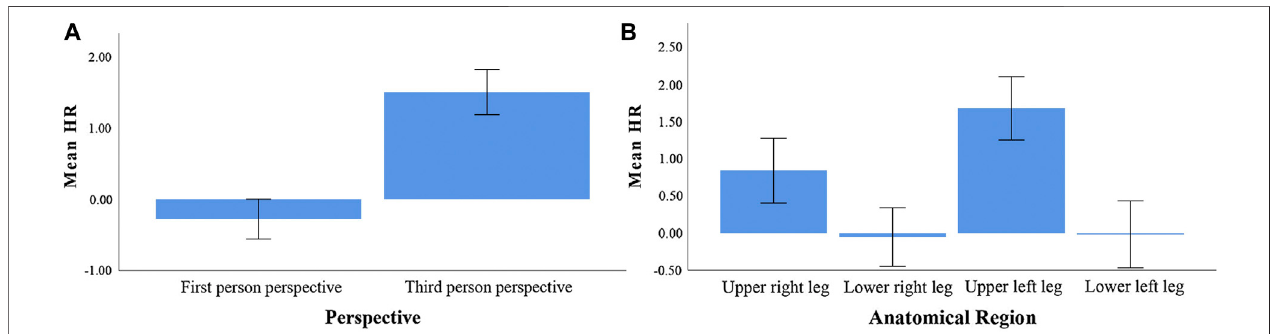
FIGURE 3 | Mean HR for perspective (A) shows that third person perspective scores higher, which did not reach signi fi cance (p (cid:1) 0.078). Anatomical region (B) showed a main effect with higher HR for upper stimulation region, which was signi fi cant (p (cid:1) 0.001). Error bars are 95% CI.